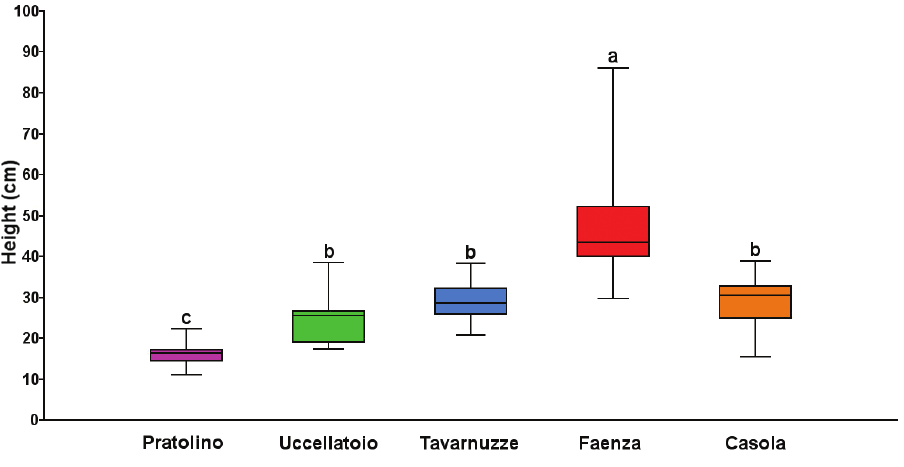
Figure 1. Boxplot of the inflorescence height (cm) in the studied Bellevalia webbiana populations. Dif- ferent letters indicate statistically significant differences at 0.01